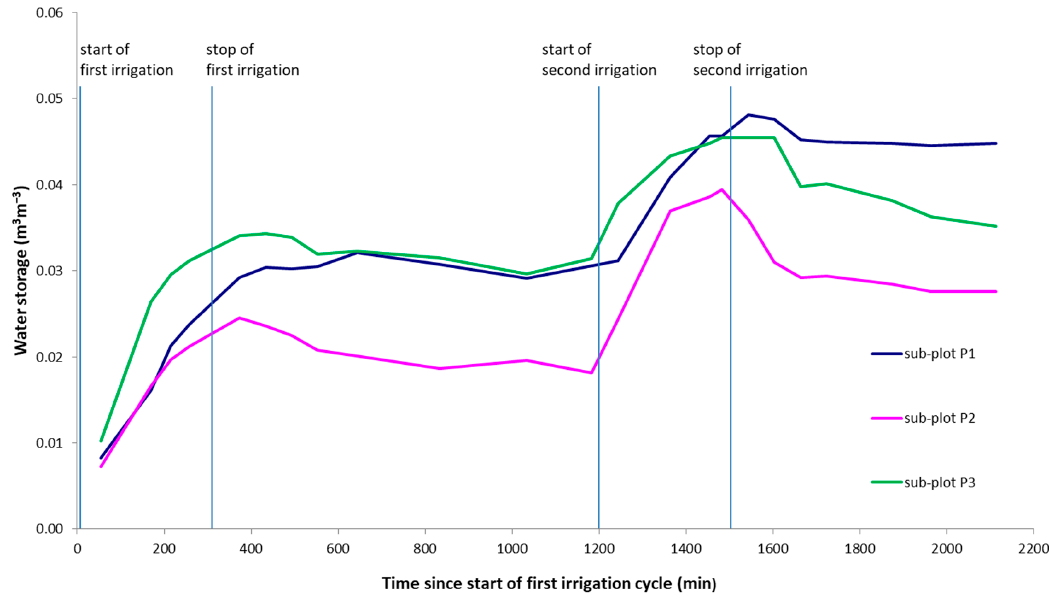
Figure 7. Water storage estimated in the three sub-plots through zeroth moment M 00.